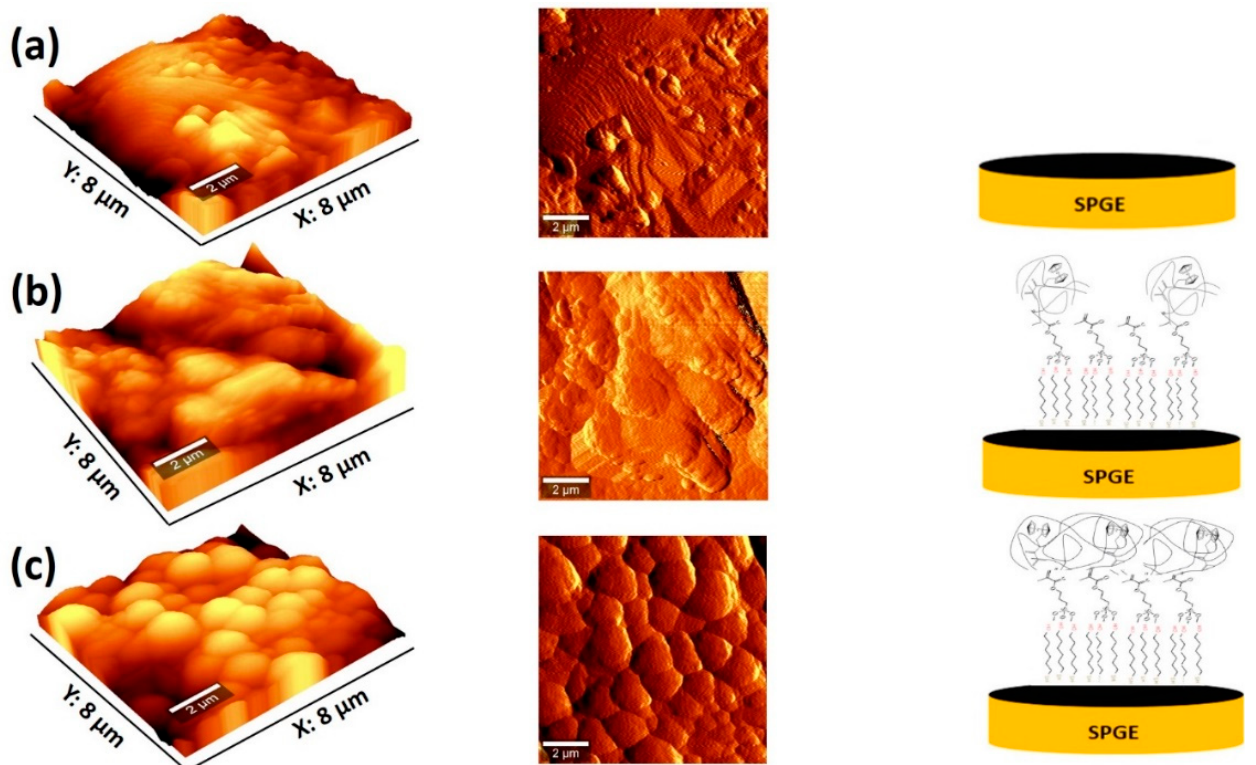
Figure 1. Atomic force microscopy. Bare electrode ( a ), NIP-modified electrode ( b ), MIP-modified electrode ( c